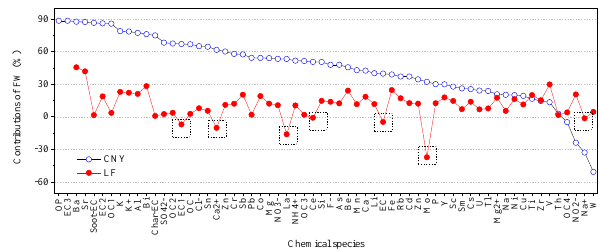
Figure 8. Contributions of firework burning (FW) on CNY and LF to chemical species in PM 2 . 5 . CNY means Chinese New Year day (30 January); LF means Lantern Festival day (14 February).